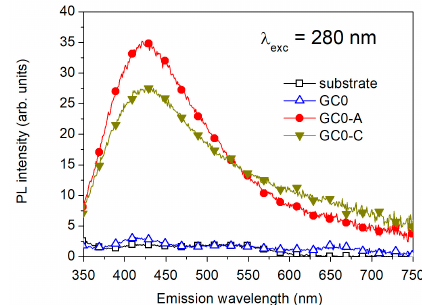
Figure 3. Photoluminescence emission by 280 nm excitation of undoped samples before Ag-exchange (GC0), after Ag-exchange (GC0-A), and after Ag-exchange and annealing (GC0-C). The substrate is also reported as a reference. The main contribution, peaked at 425 nm, is reasonably attributed to Ag + –Ag + pairs. After 1 h annealing at 430 °C, the decreasing of the blue emission in favor of the red emission suggests the formation of Ag trimers and multimers.